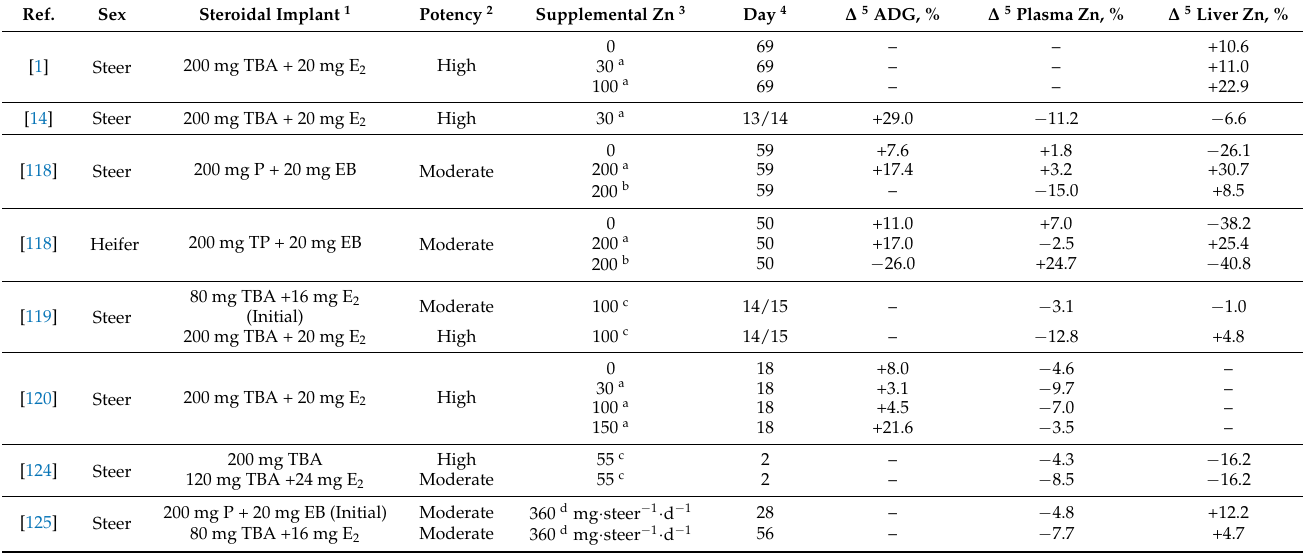
1 Steroidal implant hormone concentrations are listed using the following abbreviations: E 2 : estradiol, EB: estradiol benzoate, P: proges- terone, TBA: trenbolone acetate, TP: testosterone propionate. All steroidal implants were given as the terminal implant, unless otherwise noted as initial implant. 2 Steroidal implant potency is arbitrarily categorized as low, moderate, or high based on hormone combination and dose. 3 Supplemental Zn is expressed as mg/kg DM, unless otherwise stated. Source of Zn supplemented is represented by superscript: a inorganic, b organic, c blend of inorganic and organic, d means of inorganic and organic Zn supplementation were combined due to no source differences. 4 Represents day relative to administration of the steroidal implant used in each study. 5 The percent delta ( ∆ ) represents the effect of steroidal implant compared to non-implanted cohorts on growth and Zn metabolism parameters on the noted day post-steroidal implant administration. Changes in plasma Zn concentrations for [118] represent changes in serum Zn